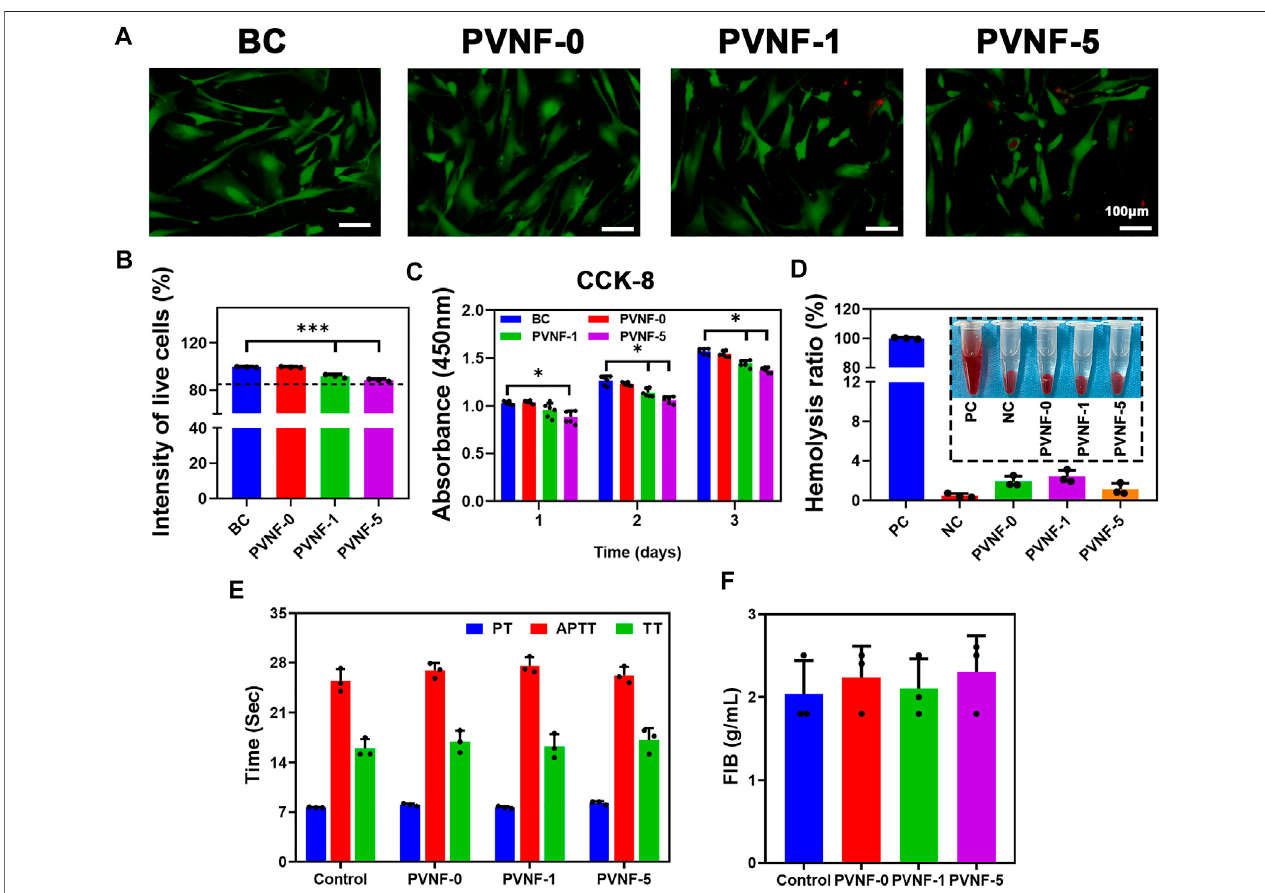
FIGURE 4| (A, B) Live/Dead staining ofthe CCC-HPF-1 cells and the intensity oflive cells ( N (cid:1) 3). (C) Cell viability of the CCC-HPF-1 cells for 1, 2, and 3 days ( N (cid:1) 5). (D) Solution of rabbit RBCs treated with the positive control (distilled water, PC), the negative control (normal saline, NC), and PVNF-n ( n (cid:1) 0, 1, and 5, respectively), followed by centrifugation. And the hemolysis ratio of rabbit RBCs ( N (cid:1) 3). (E, F) Prothrombin time (PT), activated partial thromboplastin time (APTT), thrombin time (TT), and fi brinogen (FIB) of PVNF-n ( N (cid:1) 3). Scale bar: 100 μ m * p <